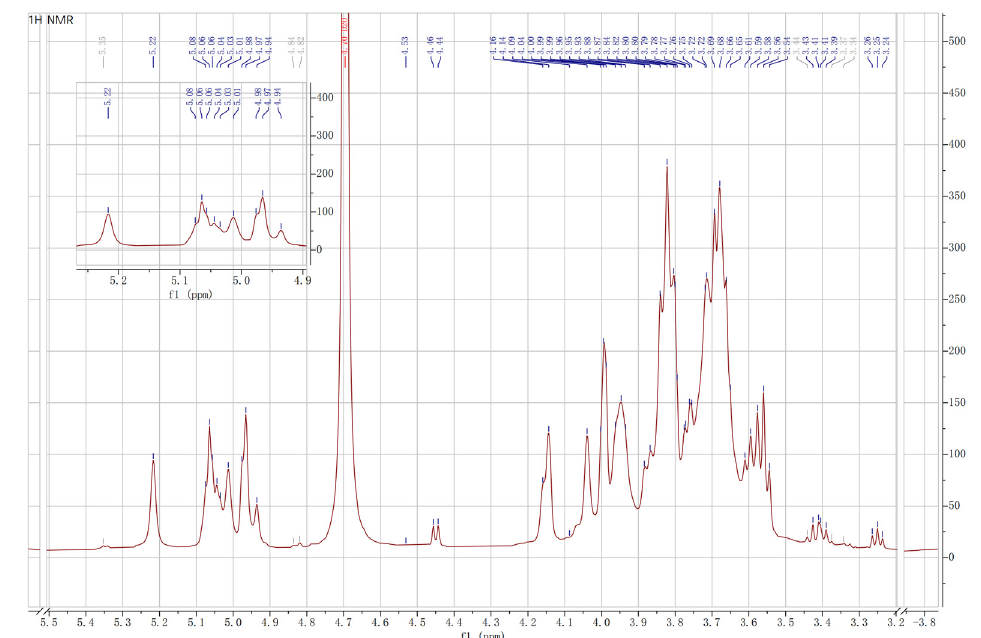
Figure 9. 1 H NMR spectroscopy of the EPS from Lpb. plantarum